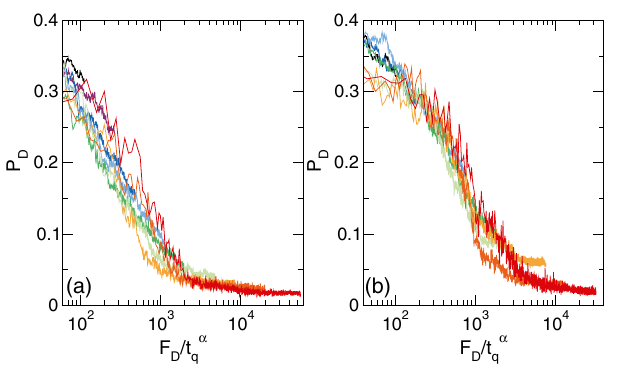
Fig. 6 Defect density scaling in the vortex and colloid systems. Dimensionless scaling plots of the defect density P D versus the scaled = t α driving force F , where t q is the quench time and where the exponent D q α = 0.625. a The vortex system from Fig. 3a. b The colloid system from Fig. 5a.